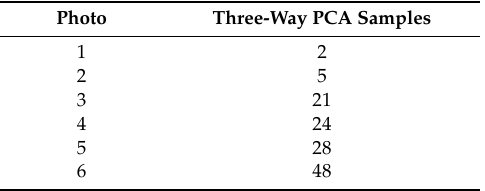
Table 6. Photo acquisition times of samples employed for three-way